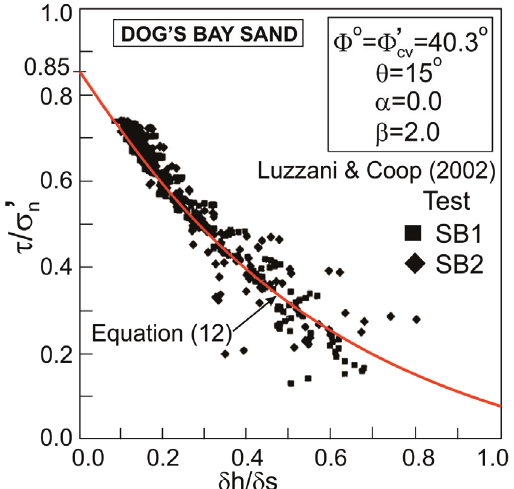
Fig. 8. Influence of the sample size on the tan  ds –  h /  s relationship: (a) small and semi-medium samples; (b) medium and large samples